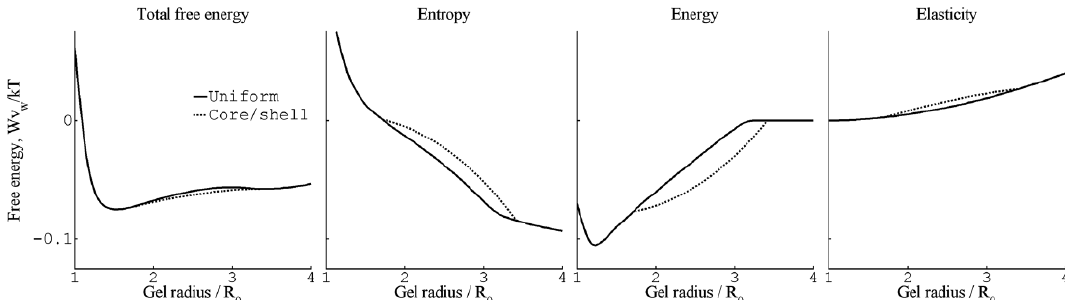
Figure 8. Contributions to the free energy of a quasi-statically compressed gel, comparing the uniform state (solid lines) to the core–shell state (dotted lines). Calculated for the system in Figure 7a, at the concentration where shell formation starts (C SF ). The free energy components are separated for clarity, but on the same scale. [72] Reproduced by permission of the Royal Society of Chemistry.